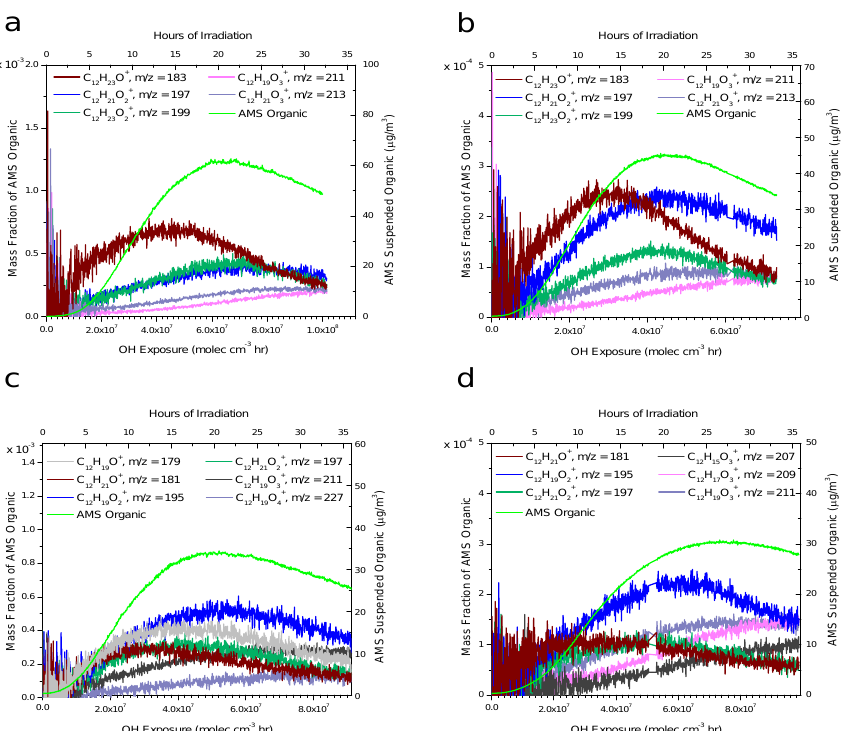
Fig. 10. Characteristic ions in (a) n -dodecane, (b) 2-methylundecane, (c) hexylcyclohexane, and (d) cyclododecane aerosol measured by the